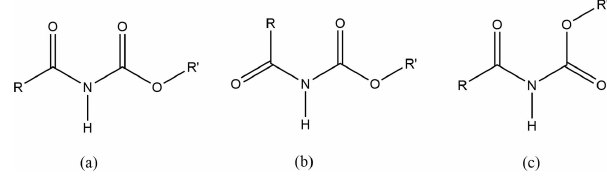
Figure 6 Conformations of amide-ester